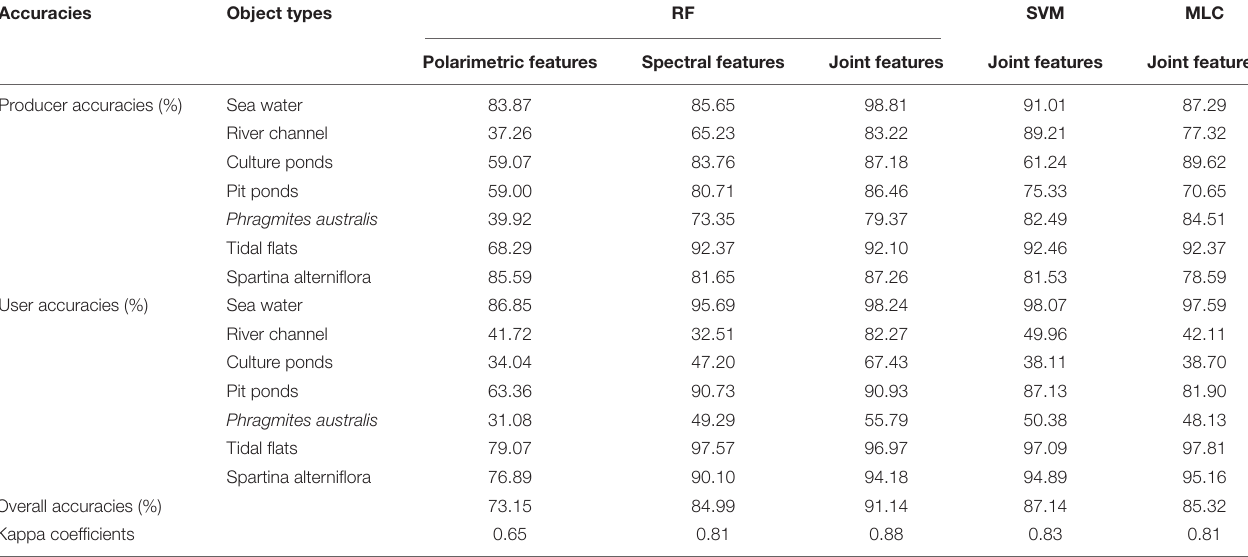
TABLE 7 | Accuracies of the extraction of wetland object types of October